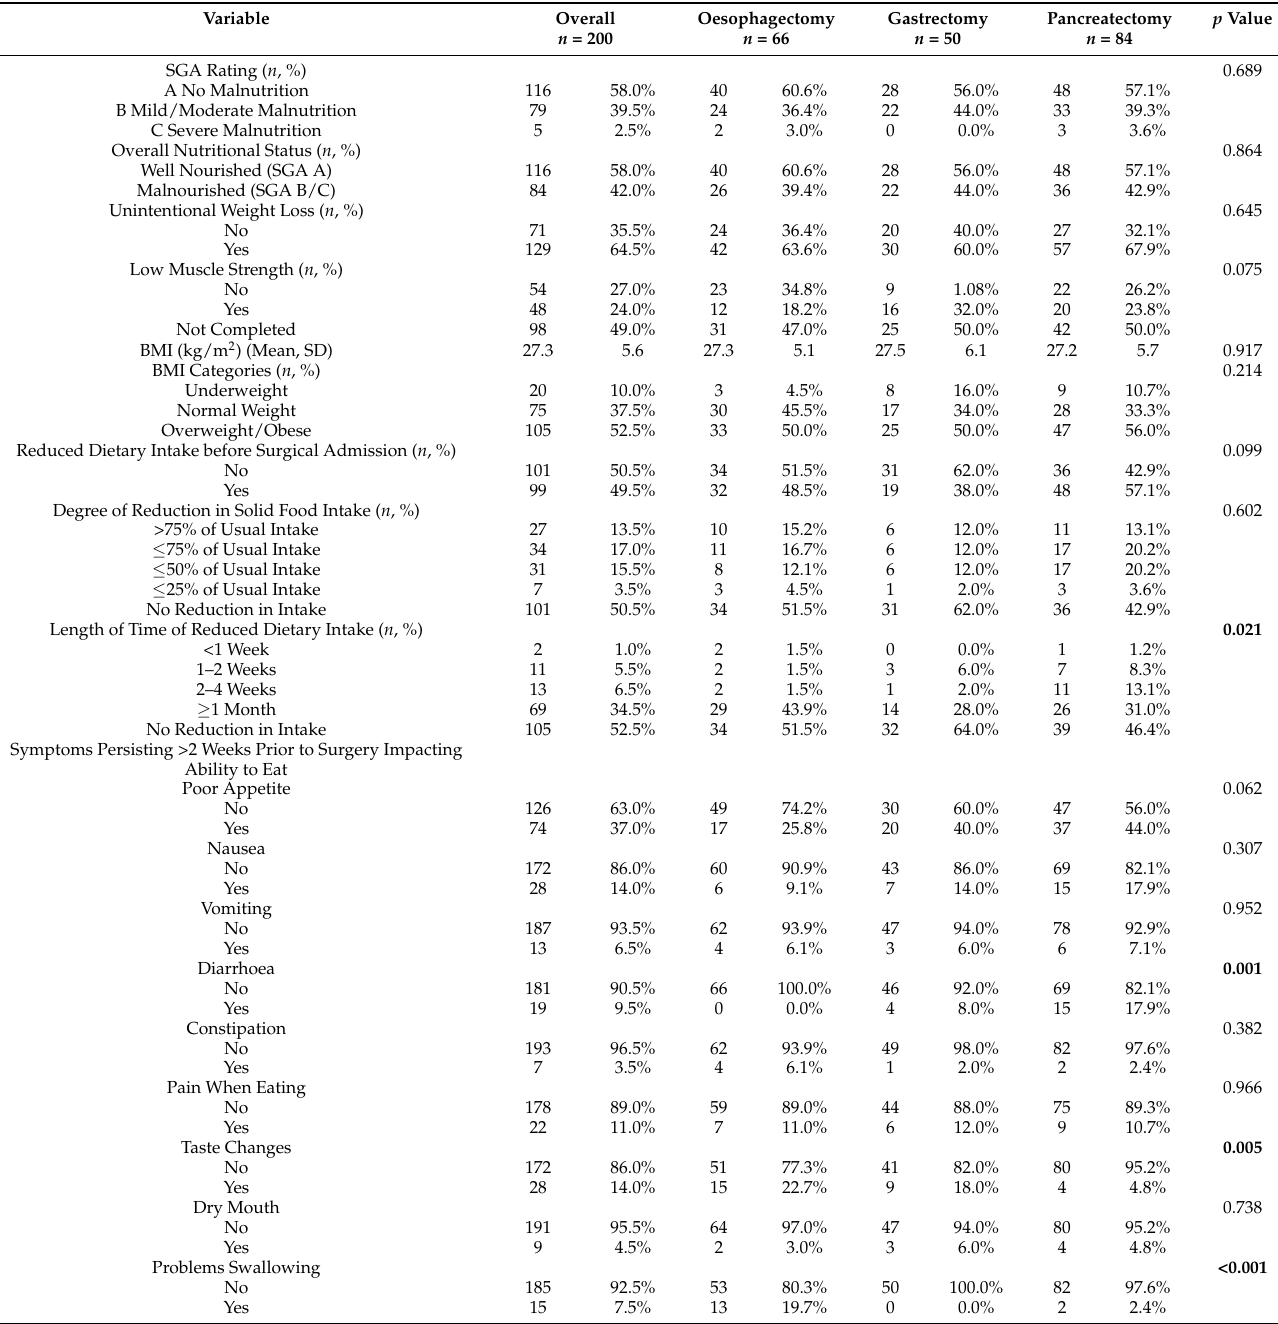
Table 2. Nutritional status and nutrition impact on symptoms by surgery